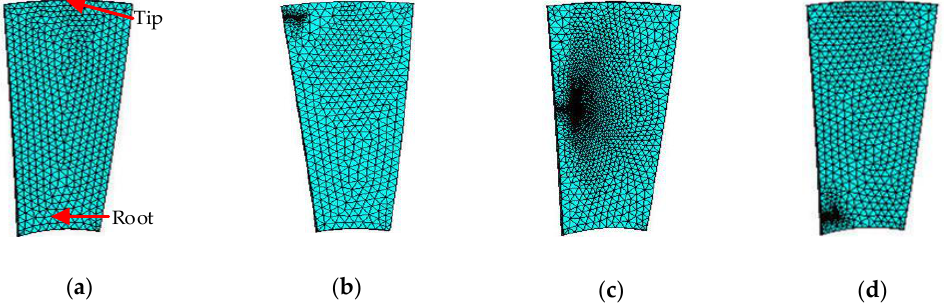
Figure 2. Blade modeling and meshing. ( a ) Flawless state; ( b ) Blade tip crack; ( c ) Blade middle crack; and ( d ) Blade root crack.